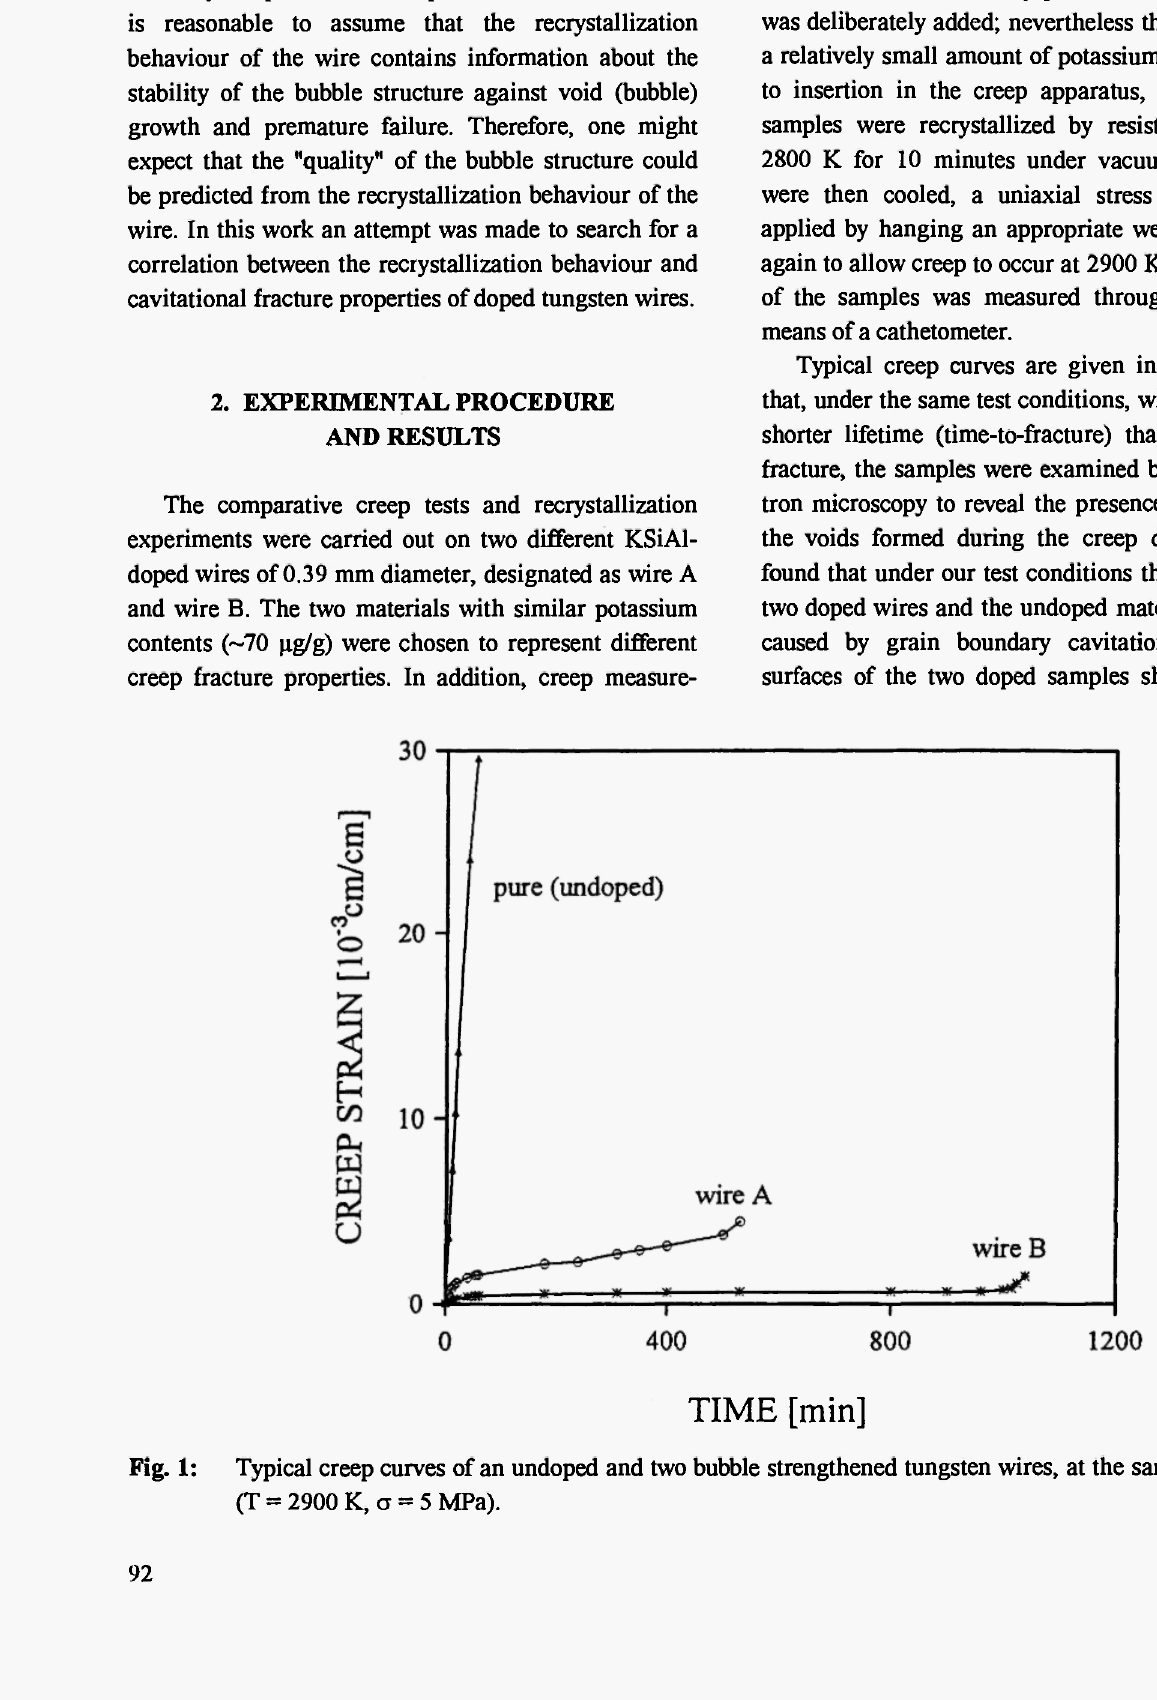
Fig. 1: Typical creep curves of an undoped and two bubble strengthened tungsten wires, at the same test conditions (T = 2900 Κ, σ = 5